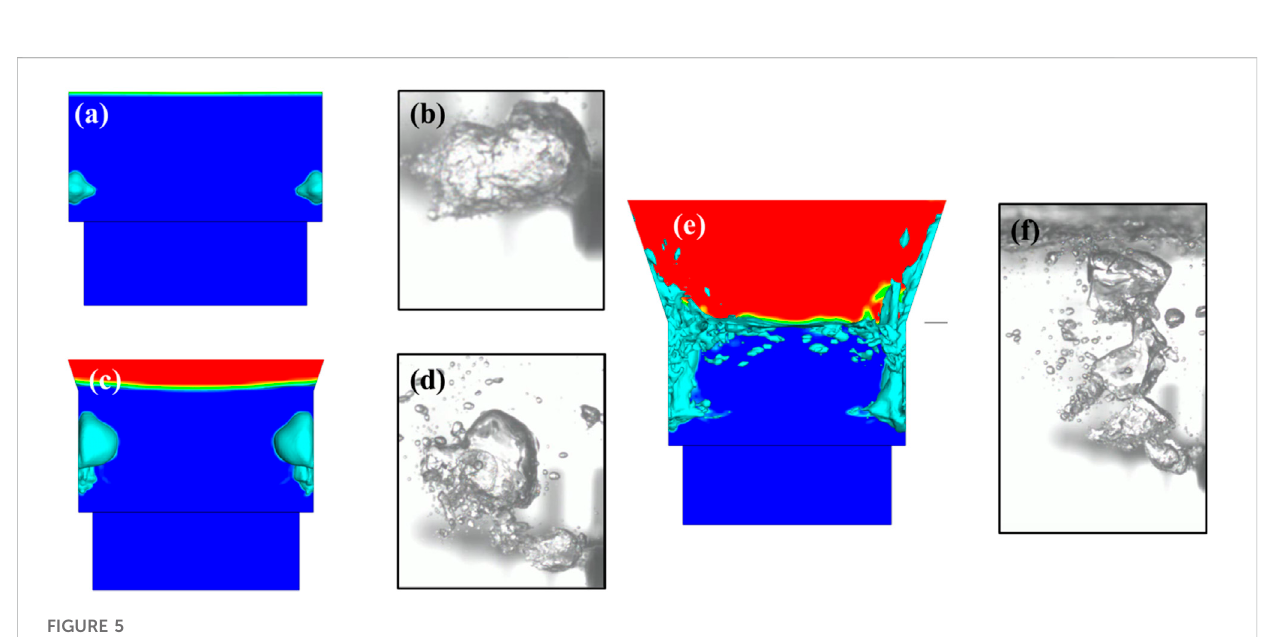
FIGURE 5 Comparison of jet pattern in the simulation and